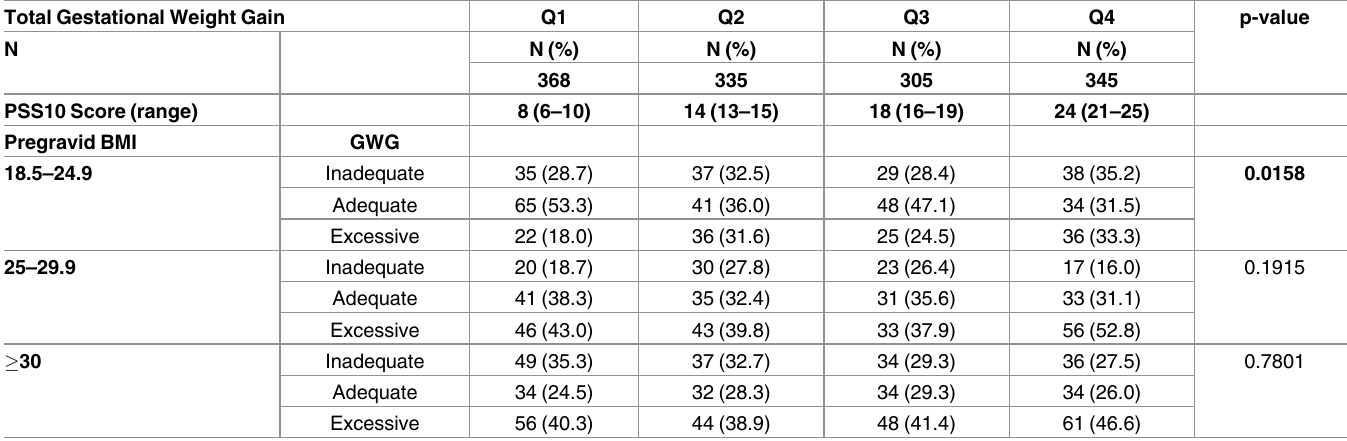
Table 2. Total GWG by stresslevel and pregravid BMI; Gestational Diabetes Effects’ on Mom (GEM) study. Total Gestational Weight